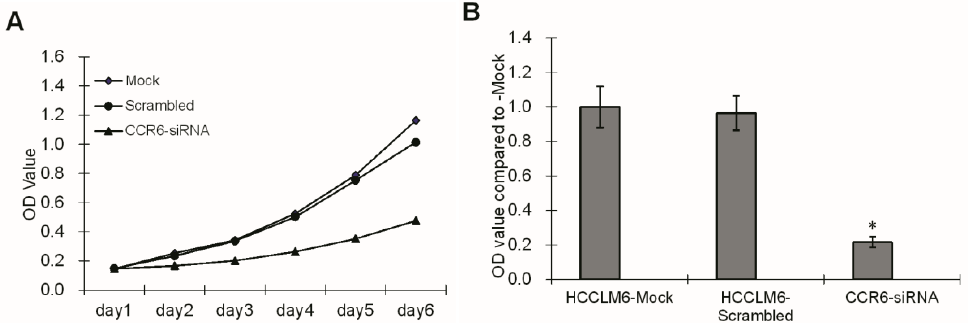
Figure 4. Proliferation and adhesion ability of HCCLM6 cells. ( A ) The cell proliferation rate of the CCR6-siRNA transfection group was obviously lower than that